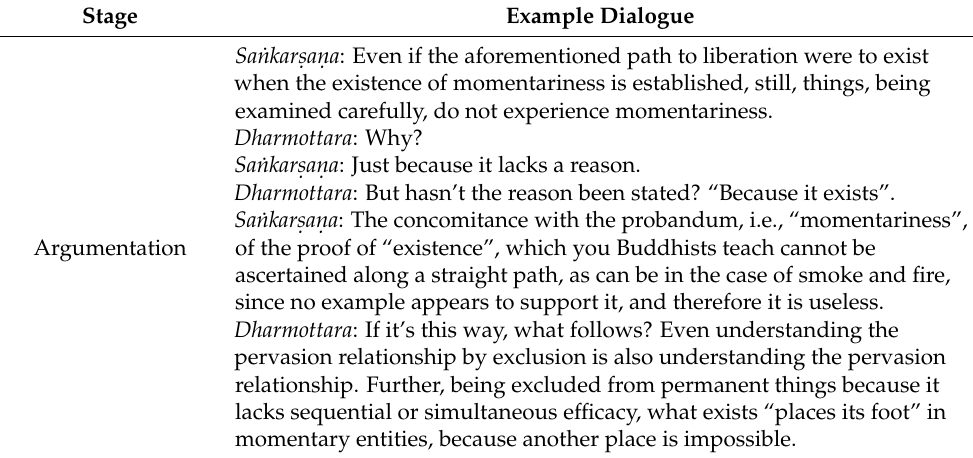
Table 5. Argumentation in Act